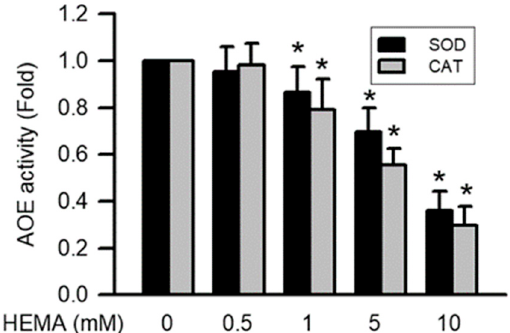
Figure 7. Activation of AOEs was reduced by HEMA in RAW264.7 macrophages. Data are expressed as mean ± SD. The number of parallel measurements is 4. * means that p < 0.05 compared with HEMA at the concentration of 0 mM.